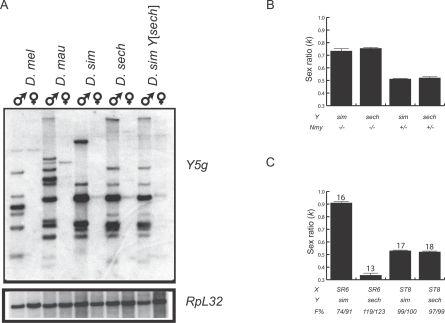
The Y Chromosome from D. sechellia Is Sensitive to Dox but Distorts SR6, Resulting in a Male-Biased Sex Ratio(A) Fingerprinting the Y chromosomes from D. melanogaster sibling species. Genomic DNA was cut with Hind III and probed sequentially with the probes Y5g and RpL32. The probe Y5g is composed of sequences from five known Y-specific genes (Figure S6). RpL32 is an autosomal gene at 99D3. Stocks used: D. mel: D. melanogaster Canton-S; D. mau: D. mauritiana w12; D. sim: D. simulans simB; D. sech: D. sechellia 3588; D. sim Y[sech]: isogenic to simB (w; nt; Nmy) except that the Y is from D. sechellia 3588, as confirmed here.(B) Test of the sensitivity of Y[sech] to Dox. Dox/Y[sim] or Dox/Y[sech] males in the background of nmy or nmy/Nmy were constructed by the following scheme: simB or D. sim Y[sech] males were crossed to P40L12 (w; nt; P40L12 nmy/Nmy] or P40B13 (w; nt; P38B13 Nmy/Nmy) females. Ten sublines of each combination were set up by mating single F1 male (P40/Nmy) to SR1227 (w; nt; nmy) females. The following four genotypes of males were obtained in the F2: (1) Dox/Y[sim]; nmy (w Dox/Y[sim]; nt; P40L12 nmy/nmy). (2) Dox/Y[sech]; nmy (w Dox/Y[sech]; nt; P40L12 nmy/nmy). (3) Dox/Y[sim]; Nmy/nmy (w Dox/Y[sim]; nt; P40B13 Nmy/nmy). (4) Dox/Y[sech]; Nmy/nmy (w Dox/Y[sech]; nt; P40B13 Nmy/nmy). Three males of each subline were tested for sex-ratio at room temperature. Dox; nmy males express sex-ratio regardless of the origin of the Y chromosome. Y[sech] and Y[sim] are similar in their sensitivity to the sex ratio distortion effect of Dox (t-test, p = 0.341).(C) Test the sensitivity of Y[sech] to SR6. The X chromosome SR6 carries the Paris sex-ratio distorters, while ST8 is the standard nondriving chromosome. Four genotypes of SR6/Y[sech] and its controls were constructed by crossing F1 females obtained from the crosses simB or D. sim Y[sech] x C(1)RM yw; nt; Nmy to SR6 or ST8 males: (1) SR6/Y[sech] (SR6/Y[sech], nt/+; Nmy); (2) SR6/Y[sim] (SR6/Y[sim], nt/+; Nmy); (3) ST8/Y[sech] (ST8/Y[sech], nt/+; Nmy); and (4) ST8/Y[sim] (ST8/Y[sim], nt/+; Nmy). Individual males of the above four genotypes were tested for sex-ratio by crossing to three w; e females (column ± SEM, with sample size). SR6 distorts Y[sim] as reported before [81], and Nmy does not suppress SR6. Unexpectedly, Y[sech] actually distorts SR6. F%: F3 males obtained in the above sex-ratio test matings were crossed singly again to three w; e females.